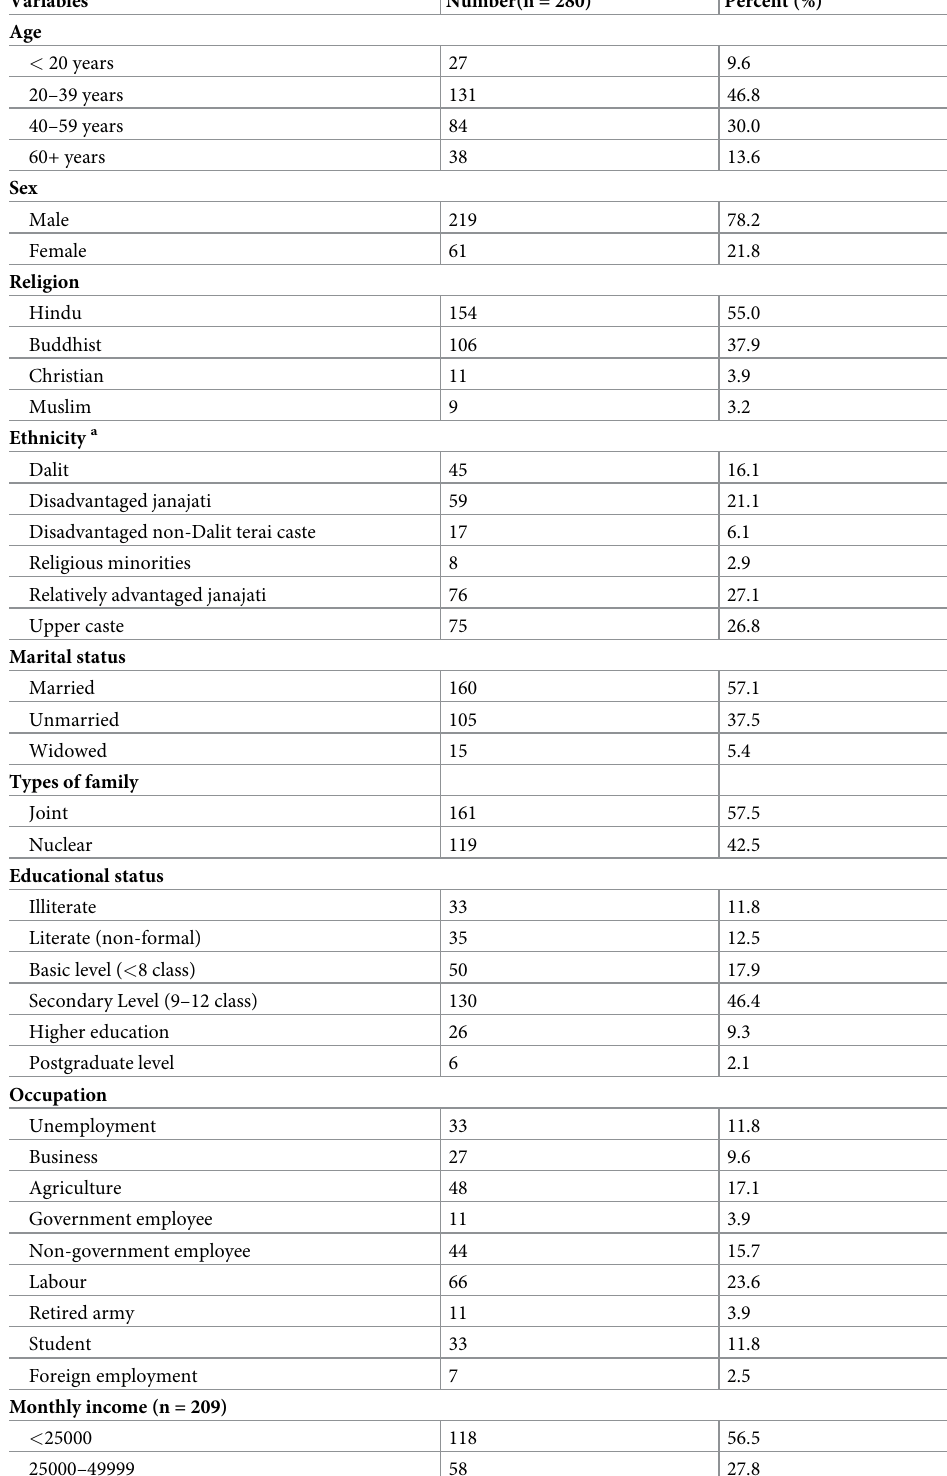
Table 1. Socio-demographic characteristics (n =